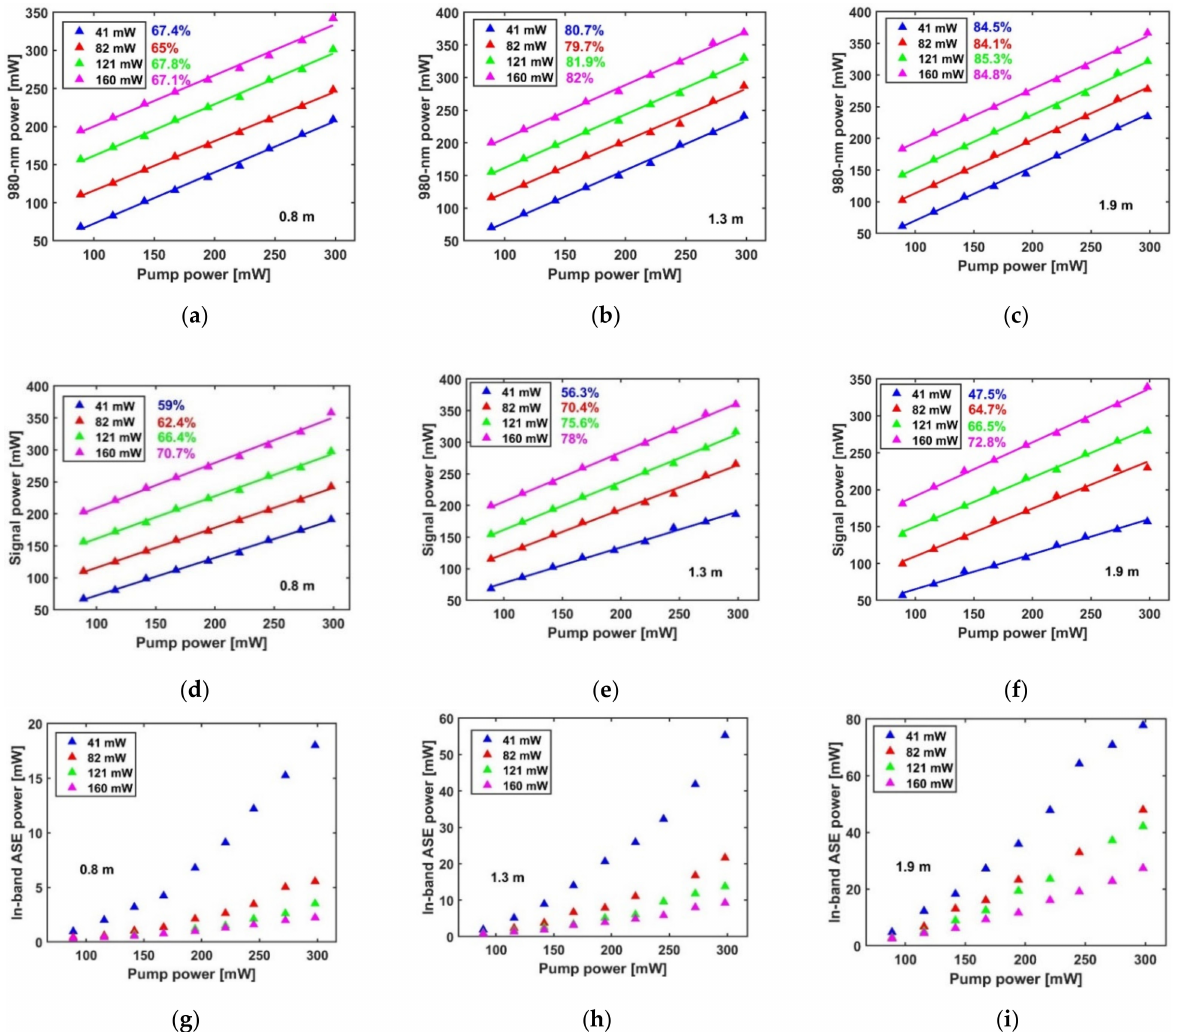
Figure 6. Output power of ( a – c ) emission around 980 nm and ( d – f ) signal light and ( g – i ) in-band ASE with 0.8-m, 1.3-m, and 1.9-m active fibers,